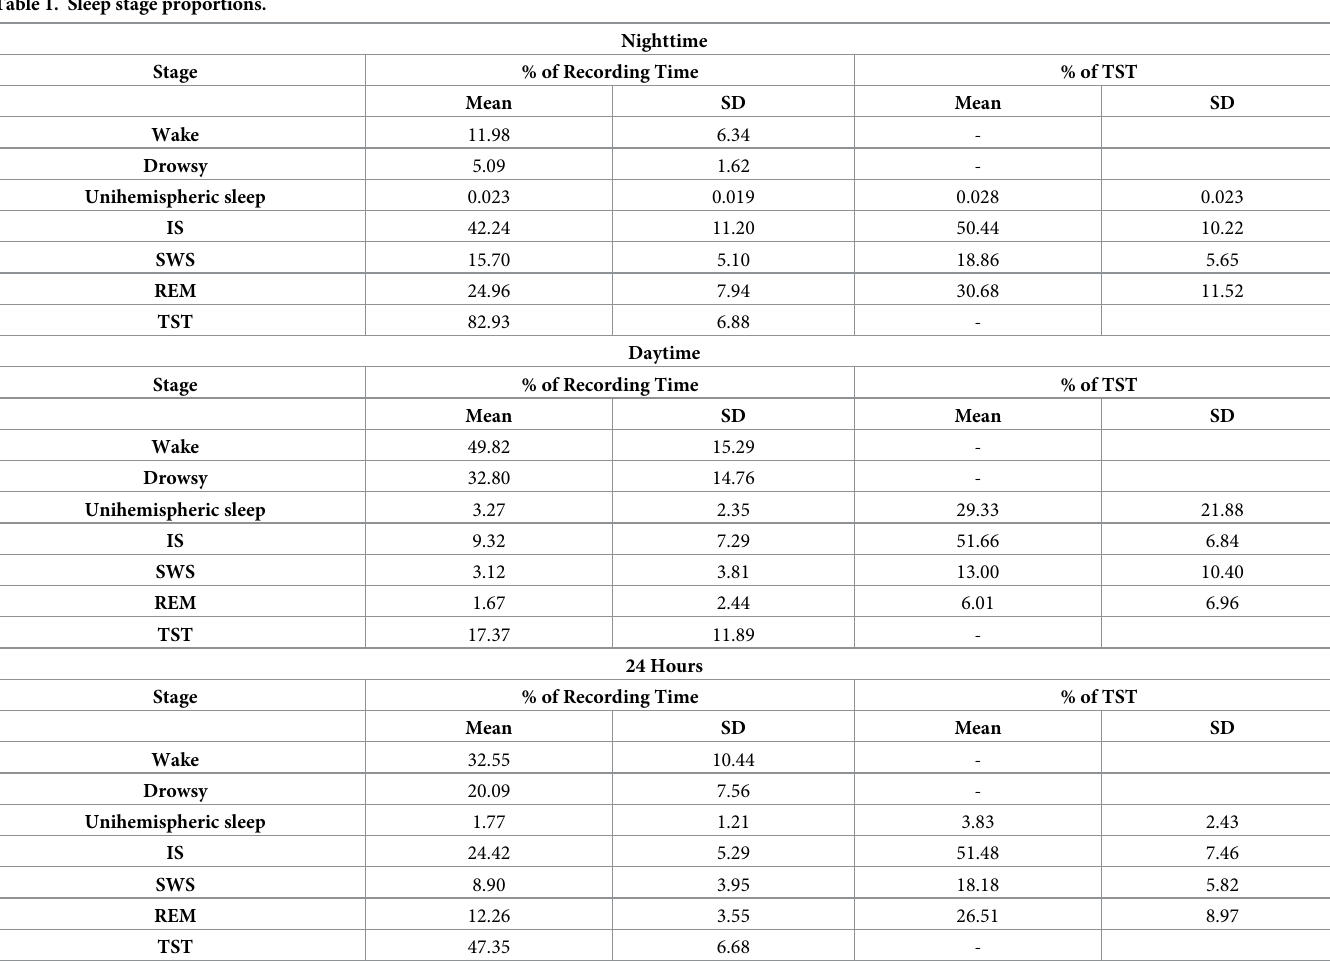
Table 1. Sleep stage